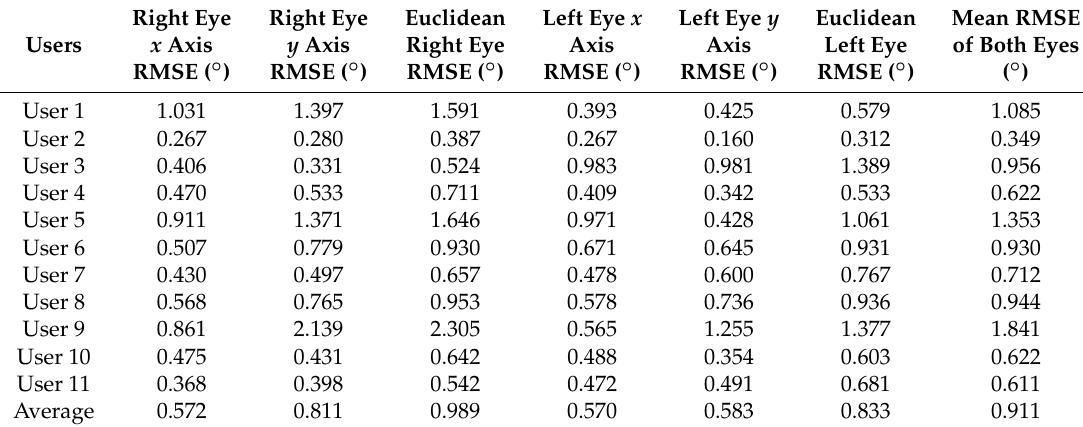
Table 5. Estimation results of gaze tracking root mean square errors (RMSE) in